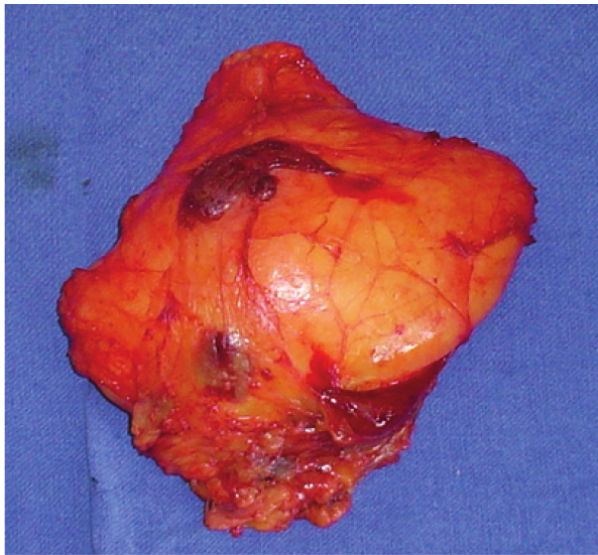
Figure 5 - Anatomical specimen with lobulated appearance and intact, translucent capsule.